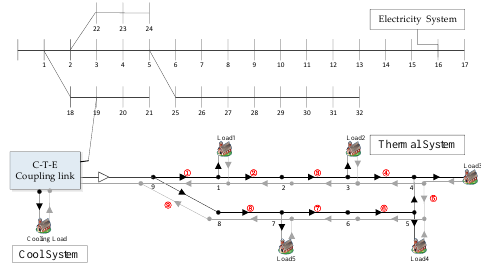
Figure 1. Topology of cooling-thermal-electric integrated energy system.